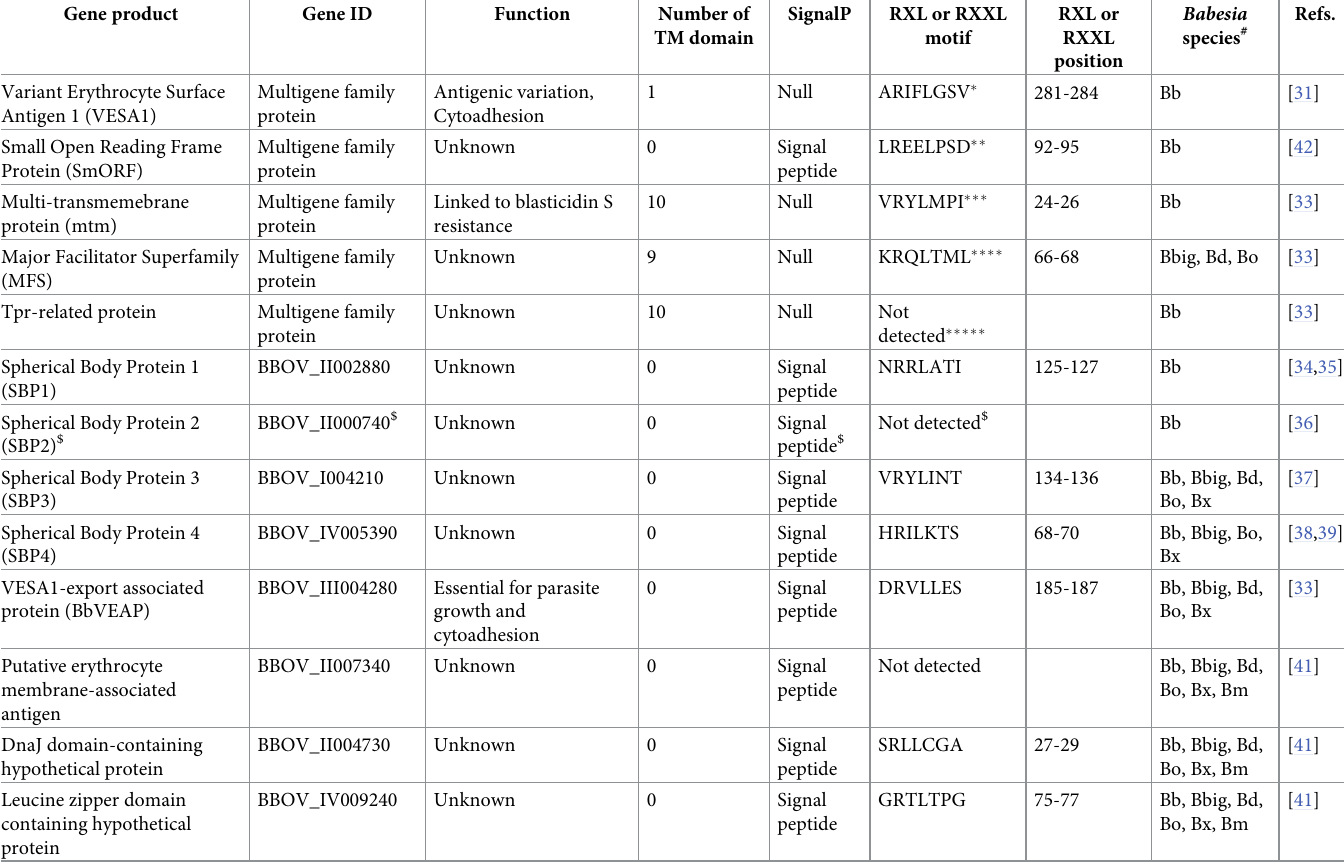
Table 1. Experimentally confirmed Babesia exportome